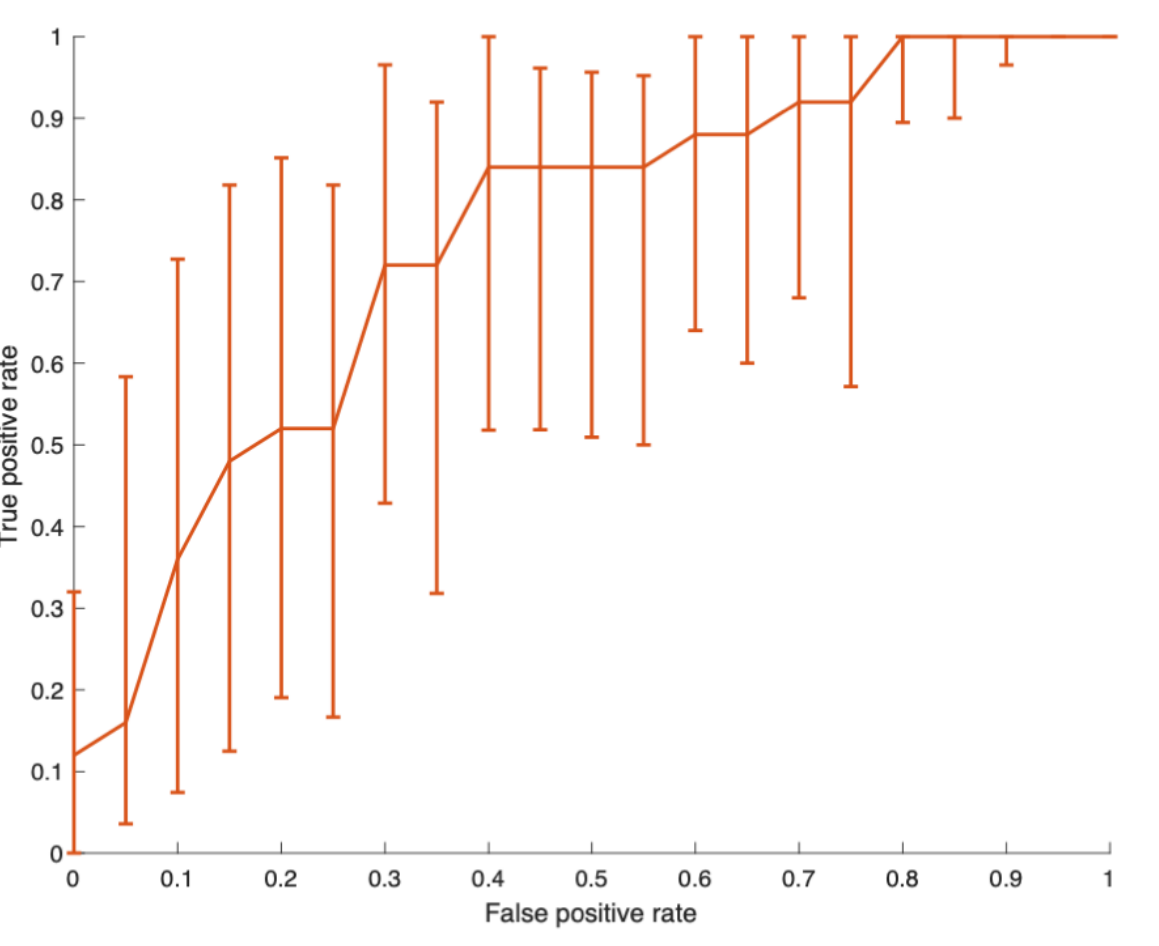
Figure 3. Classifier receiver operating characteristic curve. Vertical bars represent the 95% confidence intervals generated by 5000 bootstrap replicas. Classifier output centred to the median. Area under the curve = 0.74 (95% confidence intervals 0.59 – 0.85). 4. Discussion